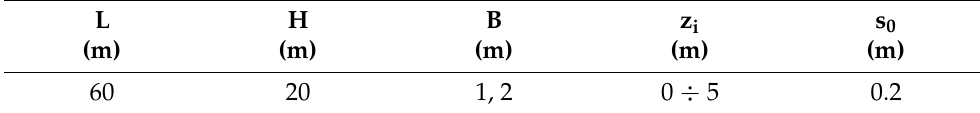
Table 1. Dimensions of the scheme reported in Figure 1.